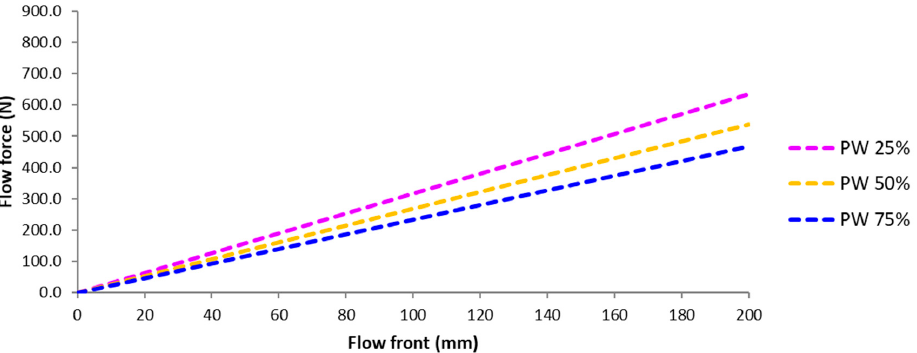
Figure 10. Predicted flow force with respect to flow front position in the multi-layered preform with various ratios of PW to UD carbon fabric.